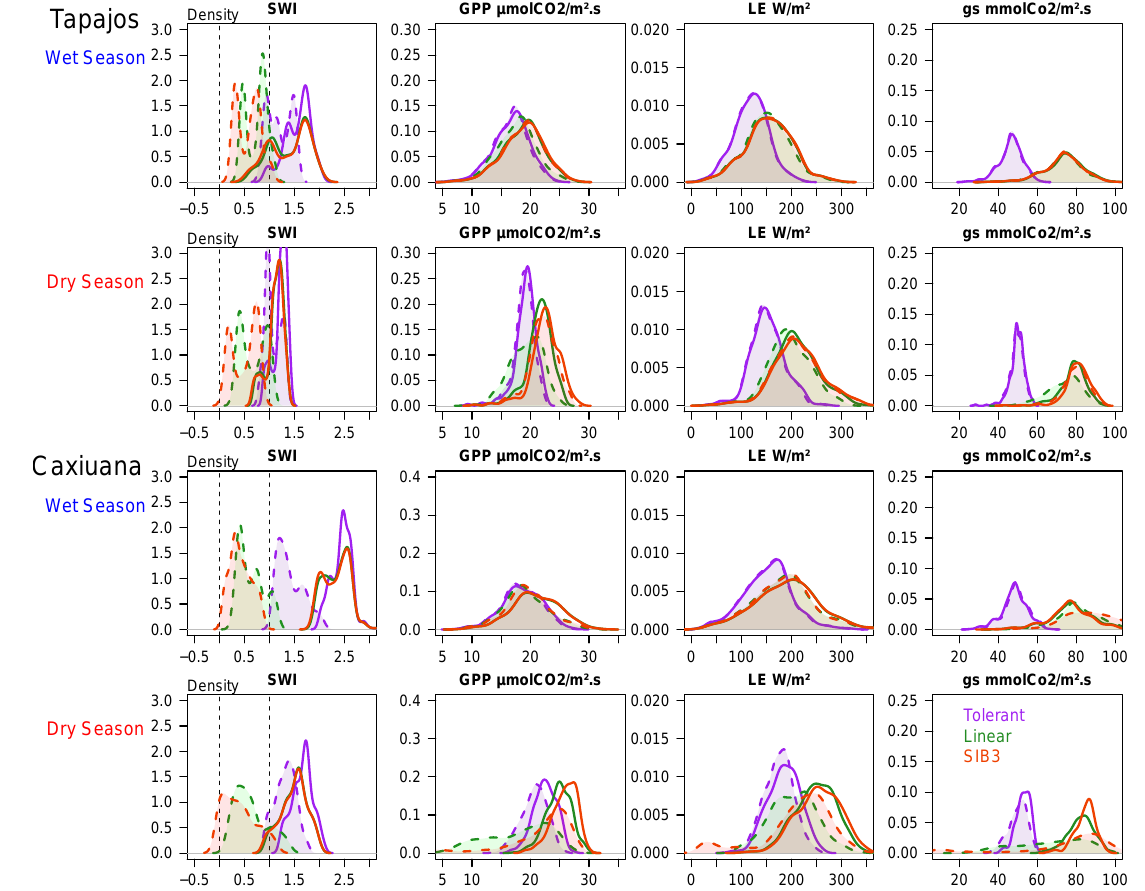
Figure 5. Probability density functions of the daily soil wetness index (SWI), gross primary production (GPP), evapotranspiration (LE) and the stomatal conductance ( g s ) , for the tolerant, linear and SiB3 water stress functions (WSFs), calculated for the dry season (from August to October) and the wet season (from February to April) during the treatment period (i.e., baseline year excluded) at Caxiuanã and Tapajós. Solid lines indicate the control (CTL) plots and dashed lines and shaded areas the throughfall exclusion (TFE) plots. The daily means are calculated for incoming short-wave radiation > 100Wm − 2 .